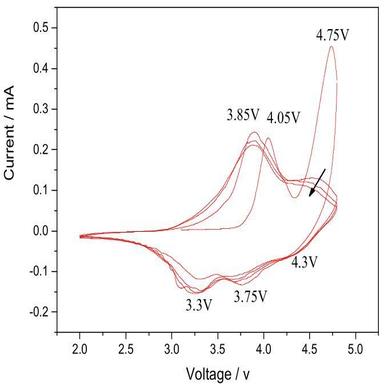
Cyclic voltammetry curves of r-LRMLO electrode in initial four cycles at a scan rate of 0.1 mV s−1.